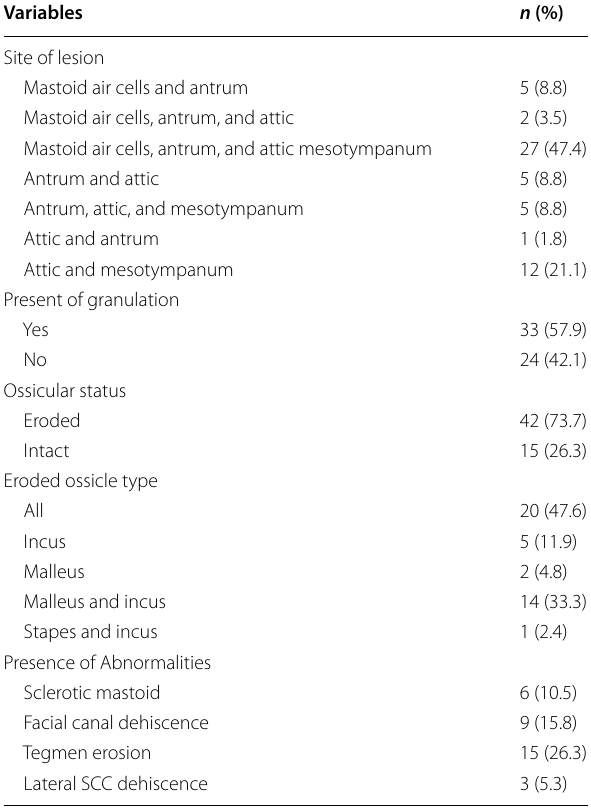
Table 2 Intra-operative findings of the patients